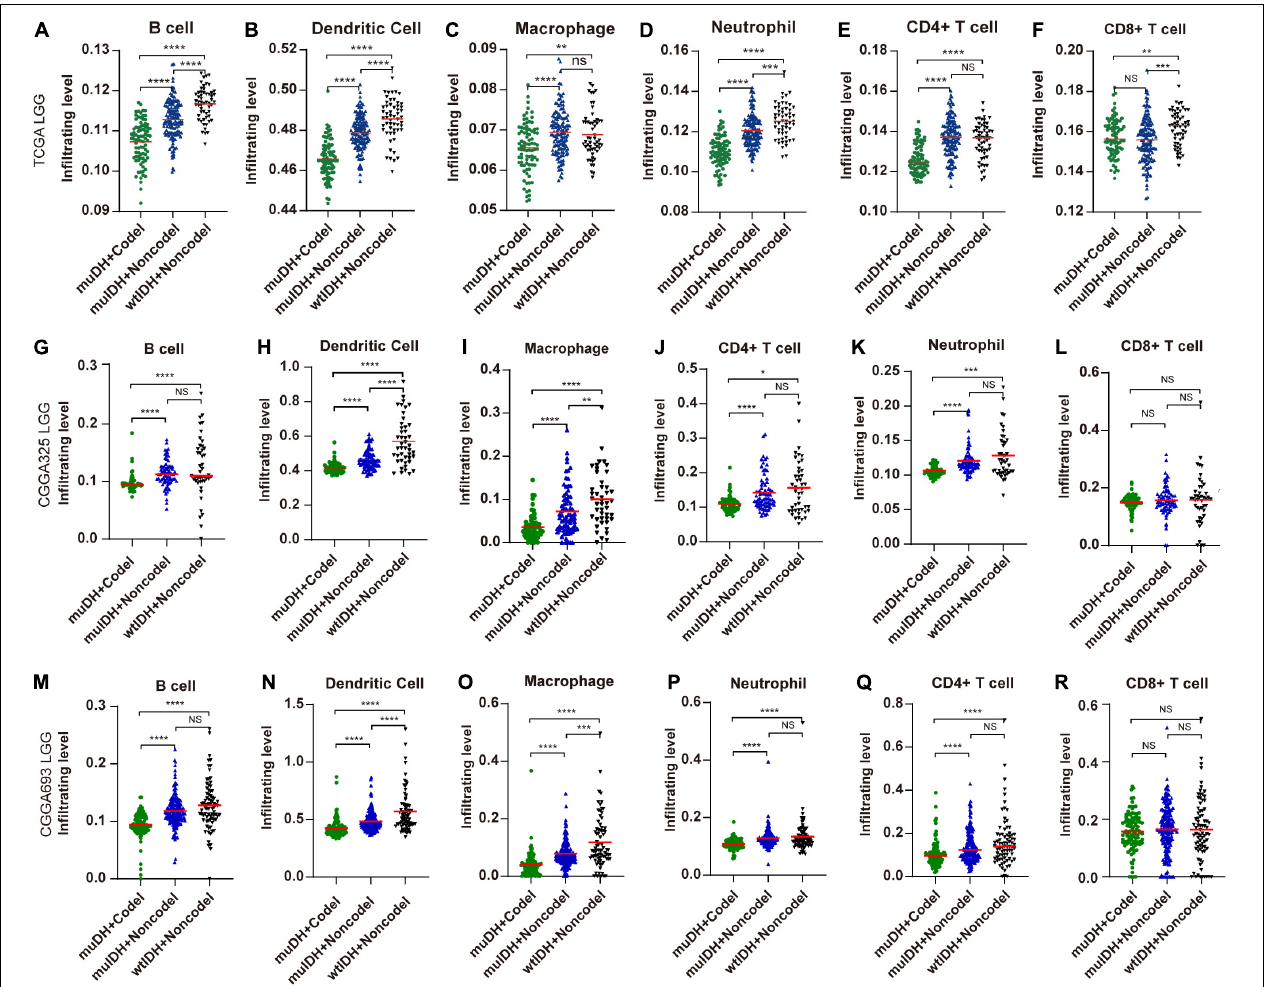
FIGURE 4 | Estimating the infiltrating level of six kinds of immune cells in LGG using TIMER tool. (A–F) Infiltrating level of six kinds of immune cell in different subgroups in TCGA LGG. (G–L) Infiltrating level of six kinds of immune cell in different subgroups in CGGA325 LGG. (M–R) Infiltrating level of six kinds of immune cell in different subgroups in CGGA693 LGG. Each symbol represents an individual patient. The number of patients in each subgroup was shown in Figure 1 . The mean scores are indicated by red lines. P values are inferred from a two-sided Student’s t -test or Mann-Whitney test. * p < 0.05, ** p < 0.01, *** p < 0.001, **** p <